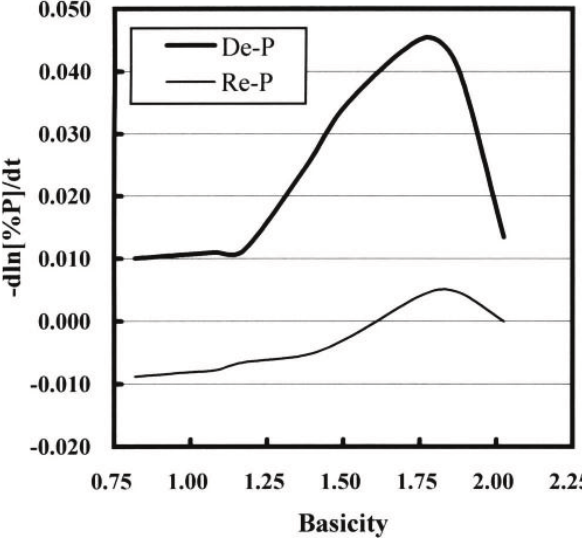
Figure 8. Calculation result to show the optimum basicity for the dephosphorization [7].